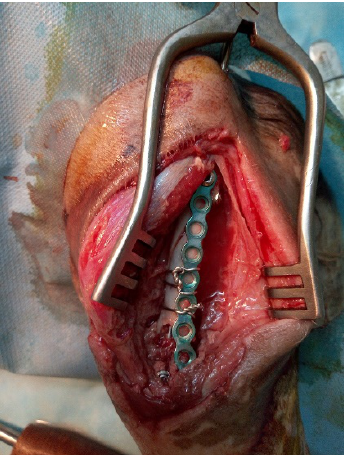
Fig. 5. Finish surgical procedure with interlocking nail, plate, screws, and wire that showed little gap between femur fragment